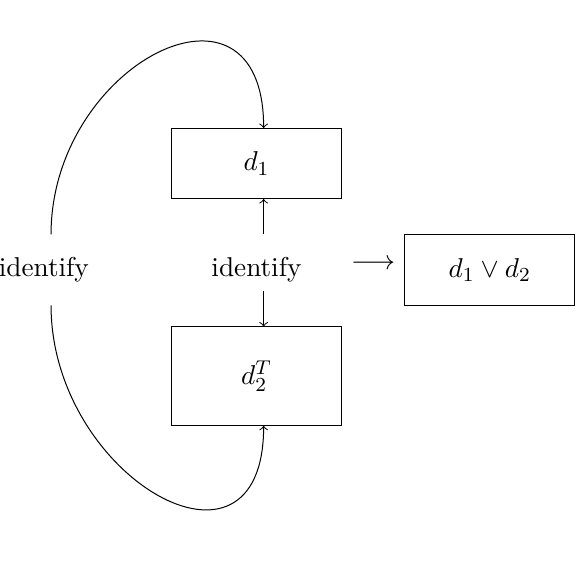
with the top vertices of d 1 , and the top vertices 2